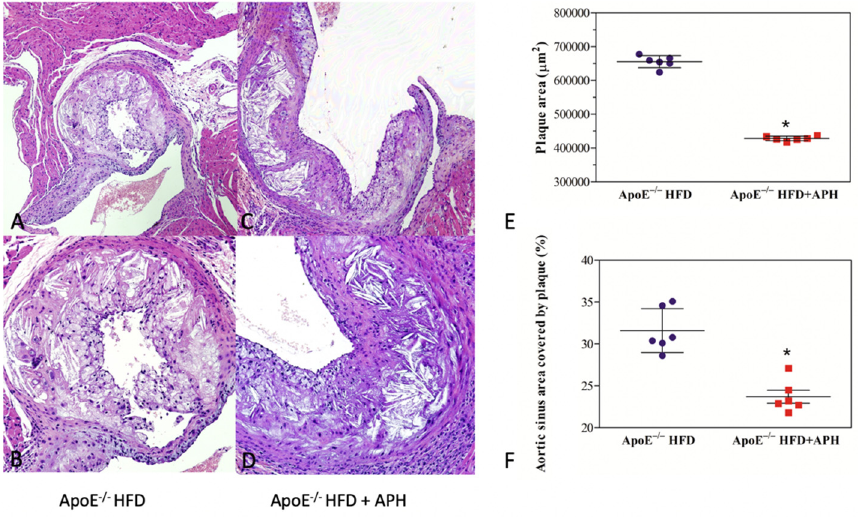
Figure 3. Histological characterization of atherosclerotic plaques in aortic sinus of ApoE − / − HFD (control) ( A , B ) and ApoE − / − HFD +APH mice ( C , D ) (HE). Quantification of plaque area, with a significant reduction in plaque area in ApoE − / − HFD+APH compared to the ApoE − / − HFD control mice ( E ) ( p < 0.001). Significant reduction in percentage of aortic sinus covered by plaque in ApoE − / − HFD + APH compared to the ApoE − / − HFD mice ( p < 0.001) ( F ). Quantification is expressed as mean ± SD for n = 6 animals per group. (Magnification 10 × , ( A , C )); (magnification 20 × , ( B , D